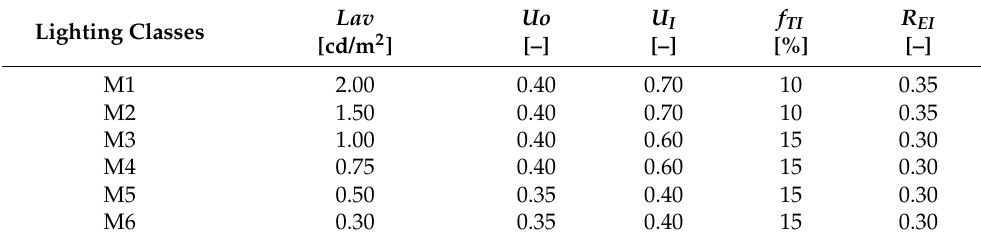
Table 1. Requirements of M road lighting classes according to EN 13201:2015